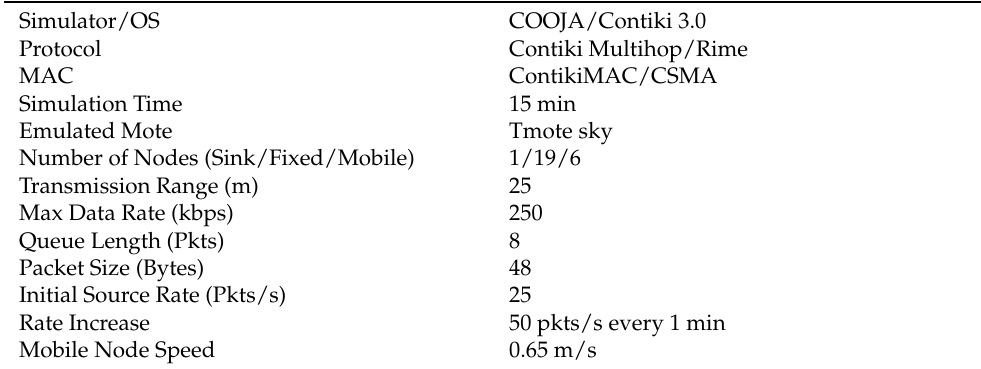
Table 1. Simulation Parameters.